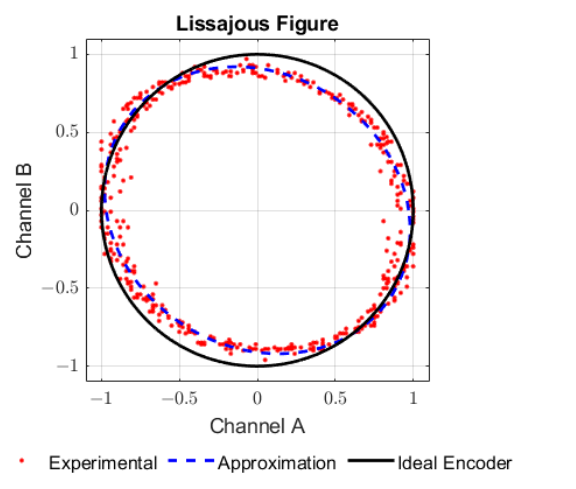
Figure 9. Lissajous figure of encoder